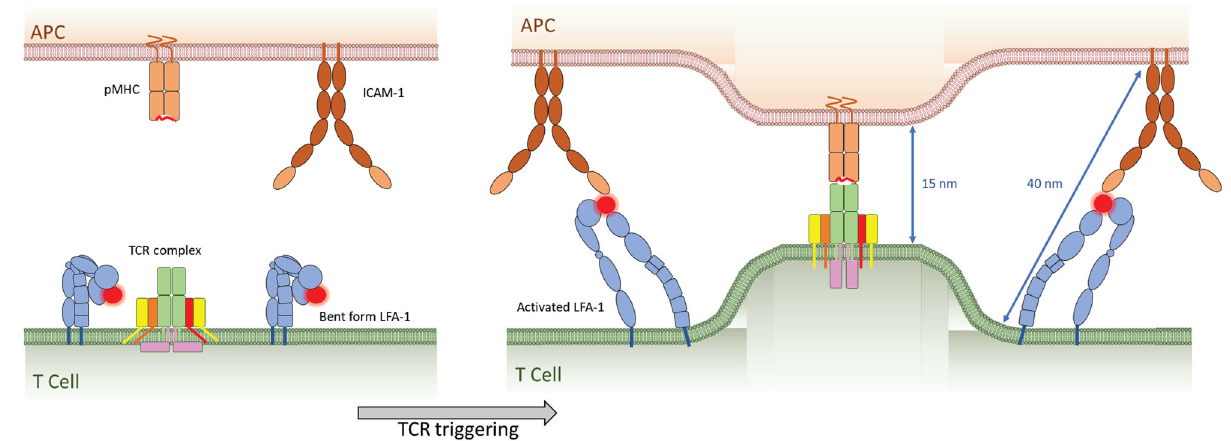
Fig. 3 Forces exerted from ICAM-1/LFA-1 engagement. Naïve T cells express LFA-1 in an inactive bent form. Inside out signaling induced upon TCR triggering converts LFA-1 to an open form that can ligate to ICAM-1 on APCs, generating a surface tension of 40 nm intercellular space around engaged pMHC/TCR complexes that span only 15 nm, which provide de fi ned molecular forces around engaged TCRs leading to